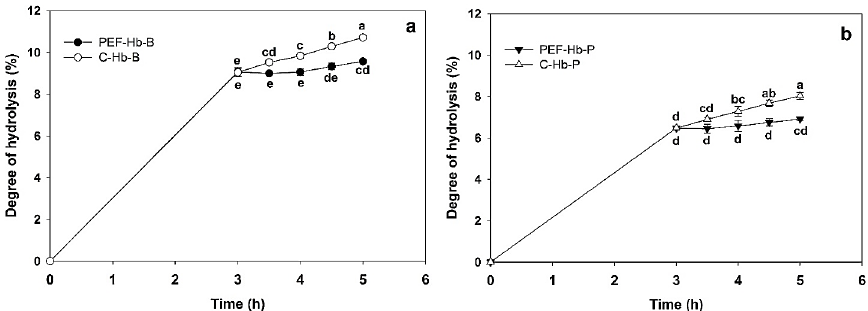
Figure 3. Evolution of degree of hydrolysis during enzymatic hydrolysis with pepsin of bovine ( a ) and porcine ( b ) hemoglobin untreated (C-Hb, control) and treated with PEFs after 3 h of hydrolysis. Different letters indicate a significant difference both between treatments and over time (Tukey test at 5%).